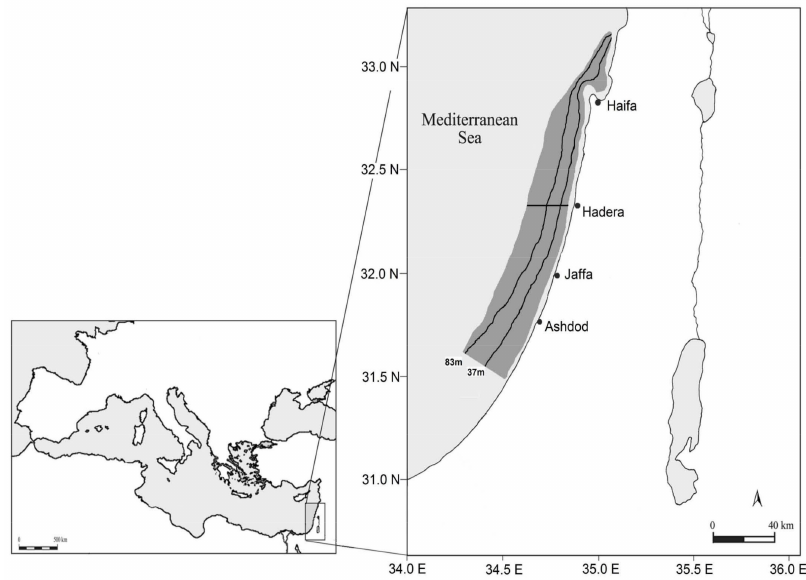
Figure 3. Map of the study site off the Israeli coast (Eastern Mediterranean Sea). N, North; E,